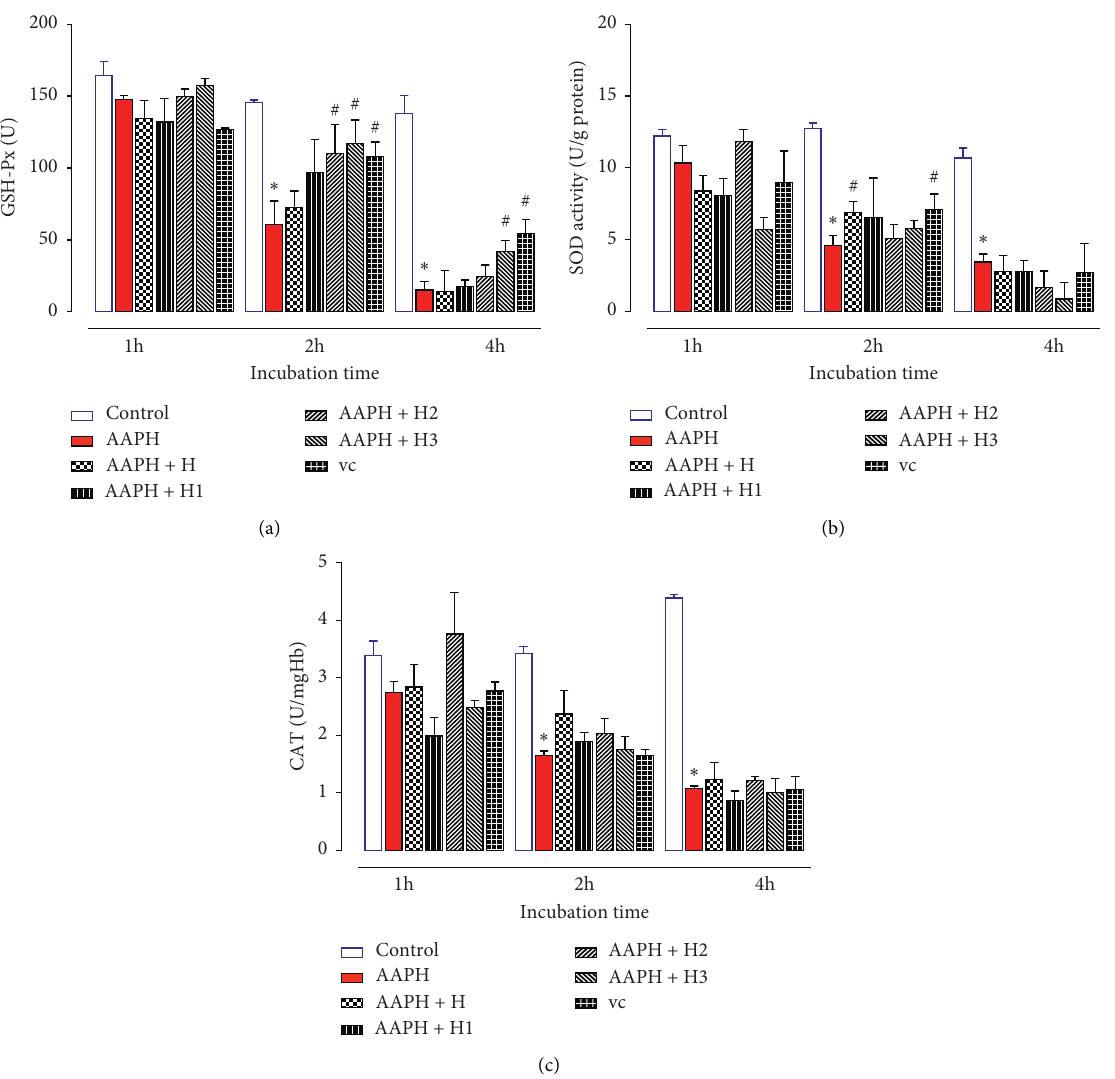
Figure 5: Effects of piperine derivatives on AAPH-induced GSH-Px levels, SOD activity, and CAT activity in rat